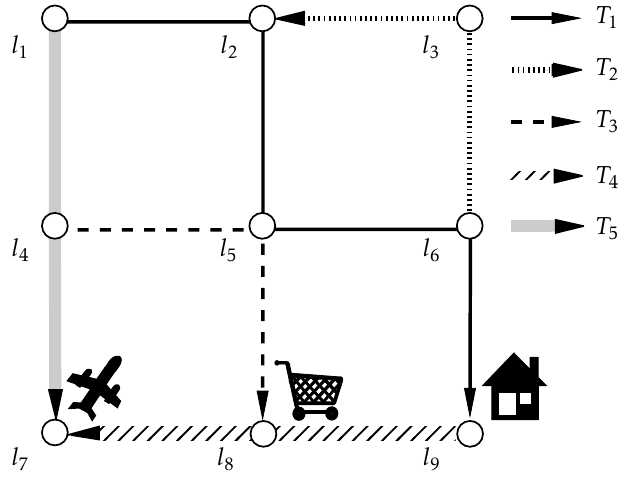
Figure 1. An example of destination